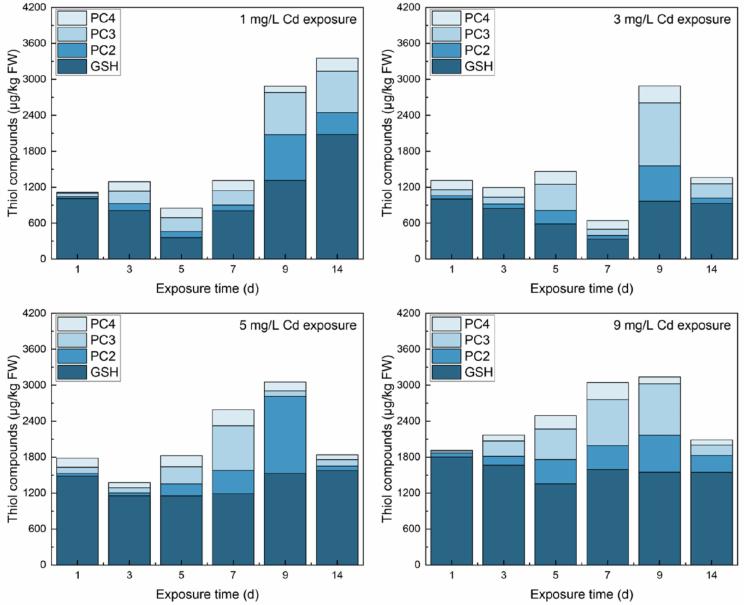
Figure 6. The total thiol in leaves under different levels of Cd